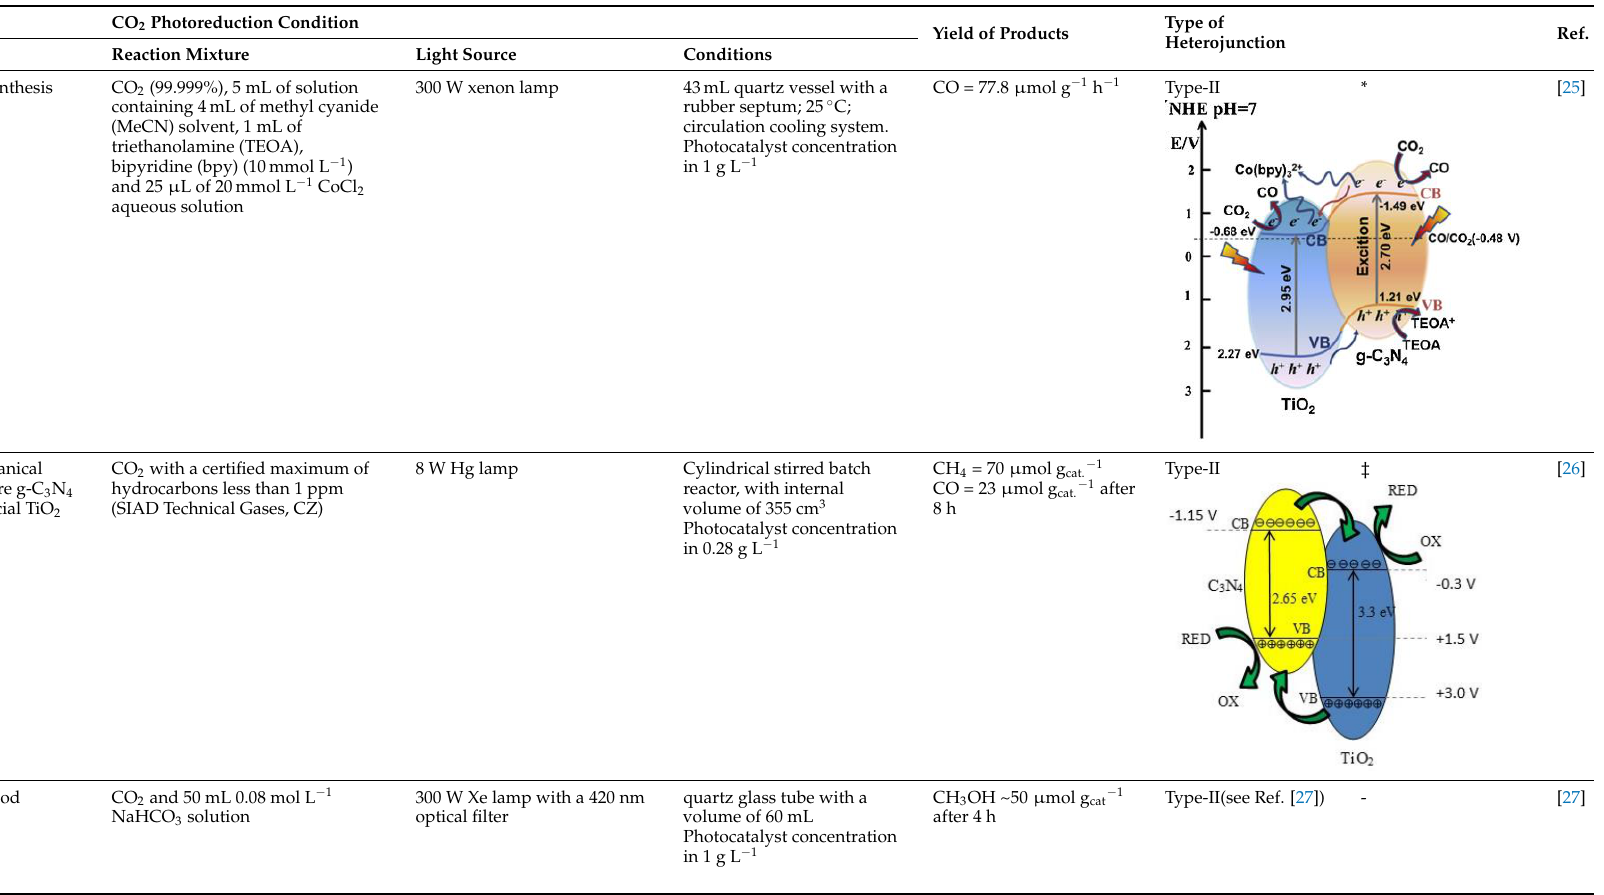
Table 2. CO 2 photoreduction using g-C 3 N 4 /TiO 2 heterojunction photocatalysts.